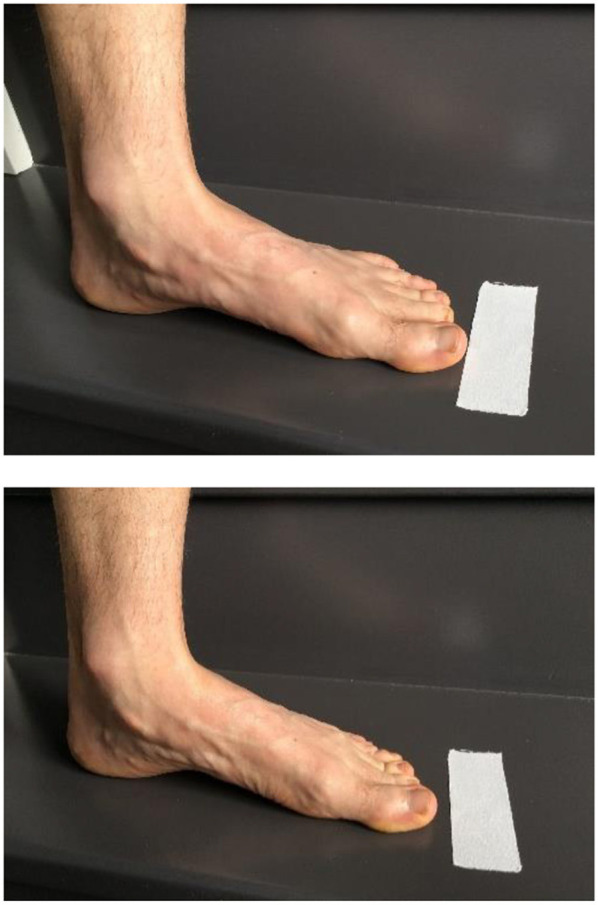
Short foot exercise.